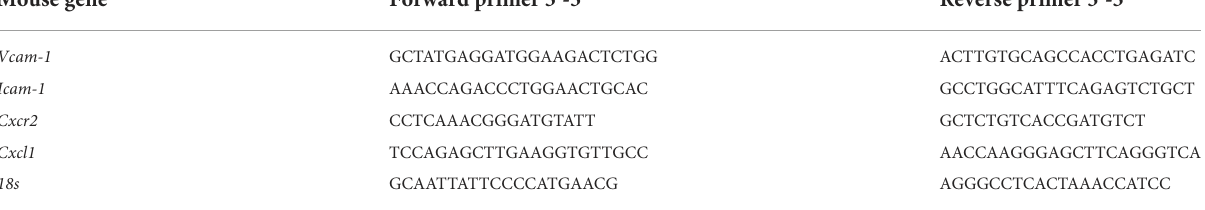
TABLE 1 Mouse primers used in quantitative real-time PCR. Mouse gene Forward primer 5 ′ -3